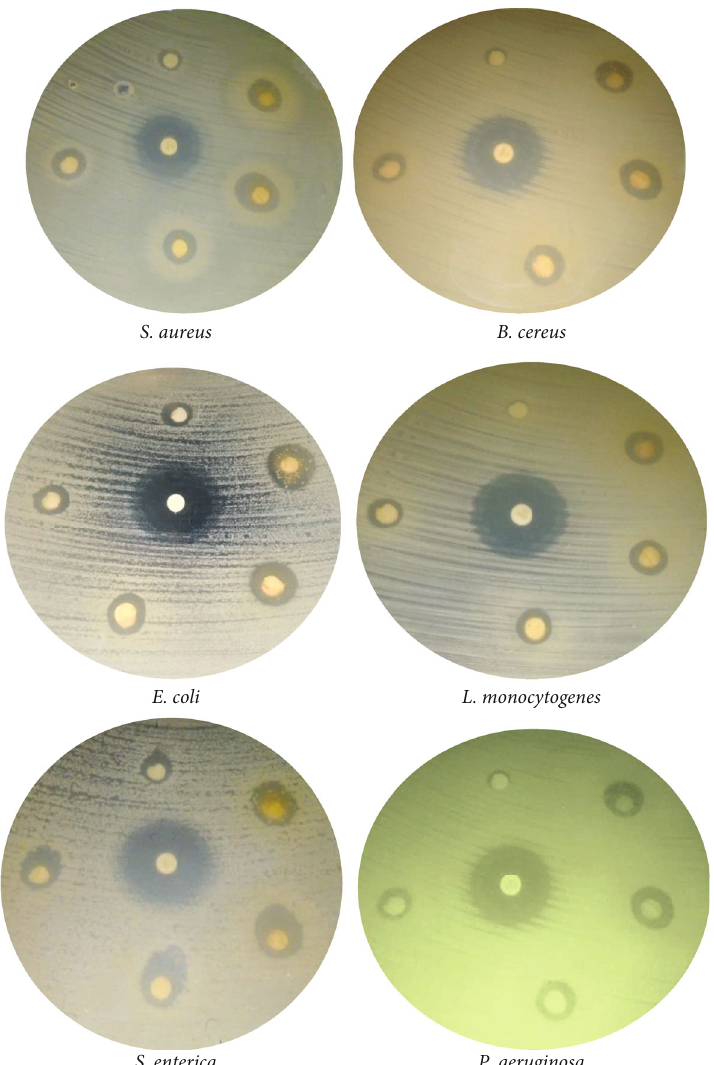
Figure 4: Secondary screening of some Streptomyces isolates and gentamicin (center) against spoilage and foodborne bacterial pathogens using the disc di ff usion